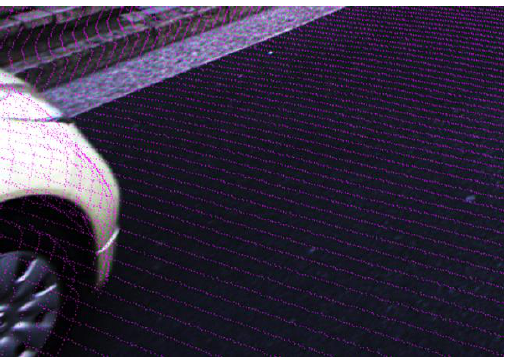
Figure 4. Density of points on image